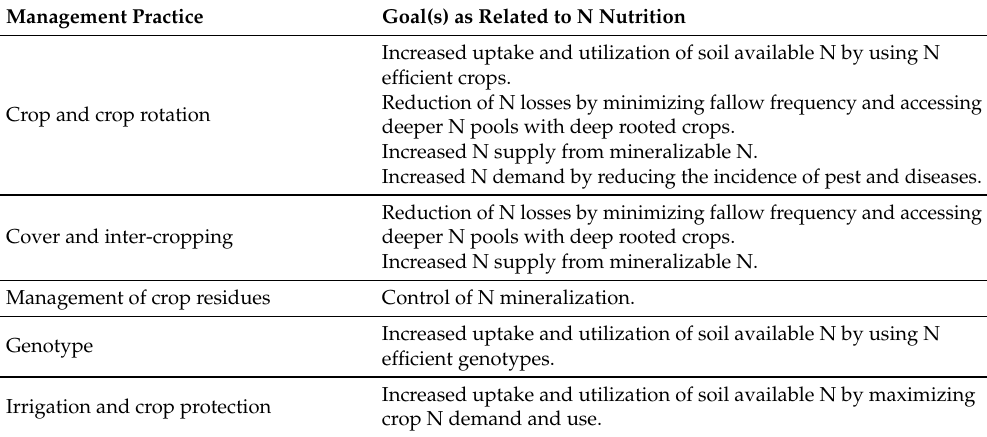
Table 4. Management practices that affect nitrogen use efficiency from Rathke et al.